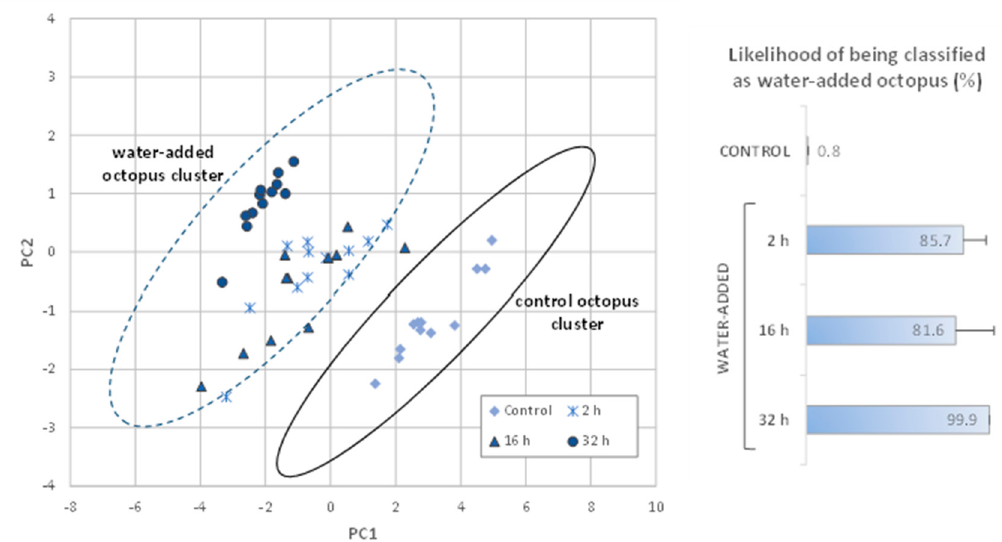
Figure 5. Validation results obtained with Octopus vulgaris samples represented in the plot of cali- bration clusters (control and water-added) and likelihood (mean ± SD) of being classified as water- added octopus. Calibration of TDR methodology was performed by means of principal components analysis—distance to reference. In the validation trial, water-added octopus were immersed in freshwater for 2, 16, and 32 h. PC1 and PC2 explained 99.5% of the variation of the original variables.